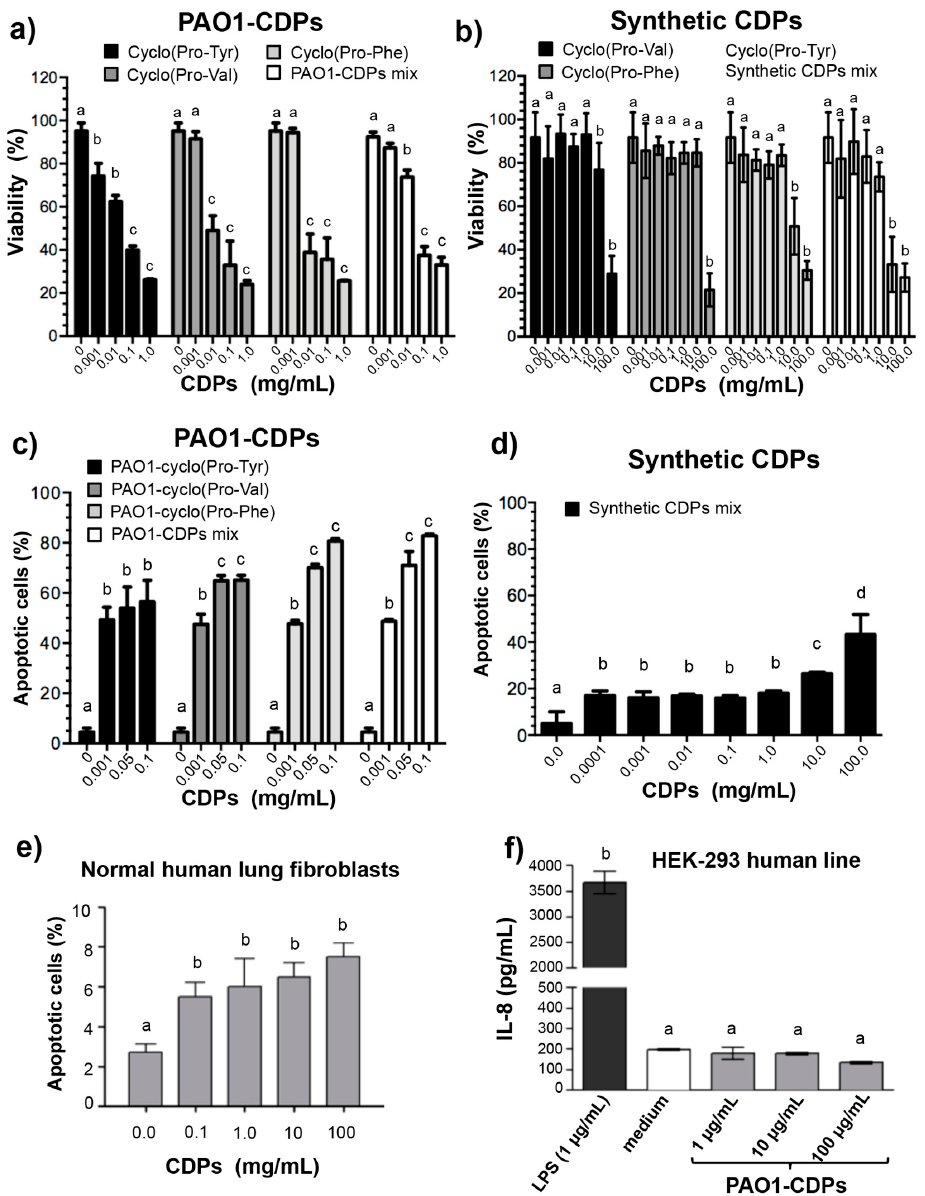
Figure 1. Effects of PAO1 and synthetic CDPs on HeLa cell viability and apoptosis induction. HeLa cells were incubated in CM medium and treated with CDPs for 24 h as described in Materials and Methods. Determination of viability of HeLa cells by an MTT assay treated with CDPs from P. aeruginosa PAO1 ( a ) and synthetic analogous CDPs ( b ). Induction of apoptosis in human HeLa cells by CDPs was analyzed in cultures grown in the CM medium and after treatment with CDPs for 24 h. Human cell lines were stained with annexin V and propidium iodide and analyzed by flow cytometry. The percentage of viability was determined by fluorescent cell quantitation in the dot plots, values were graphed as bars. Apoptosis induction in HeLa cells treated with PAO1-CDPs ( c) and with the mixture of synthetic analogs of CDPs ( d ); ( e ) Apoptosis induction in normal human lung fibroblasts by the PAO1-CDP mixture at different concentrations determined as in ( c ); ( f ) IL-8 induction in HEK-293 cells by ELISA assay as described in Materials and Methods. Bars represent mean ± standard error (SE) of three independent experiments, n = 6. One-way analysis of variance (ANOVA) was carried out, with Tukey’s post hoc test; statistical significance ( p < 0.01) of differences between treatments is indicated with different lowercase letters.